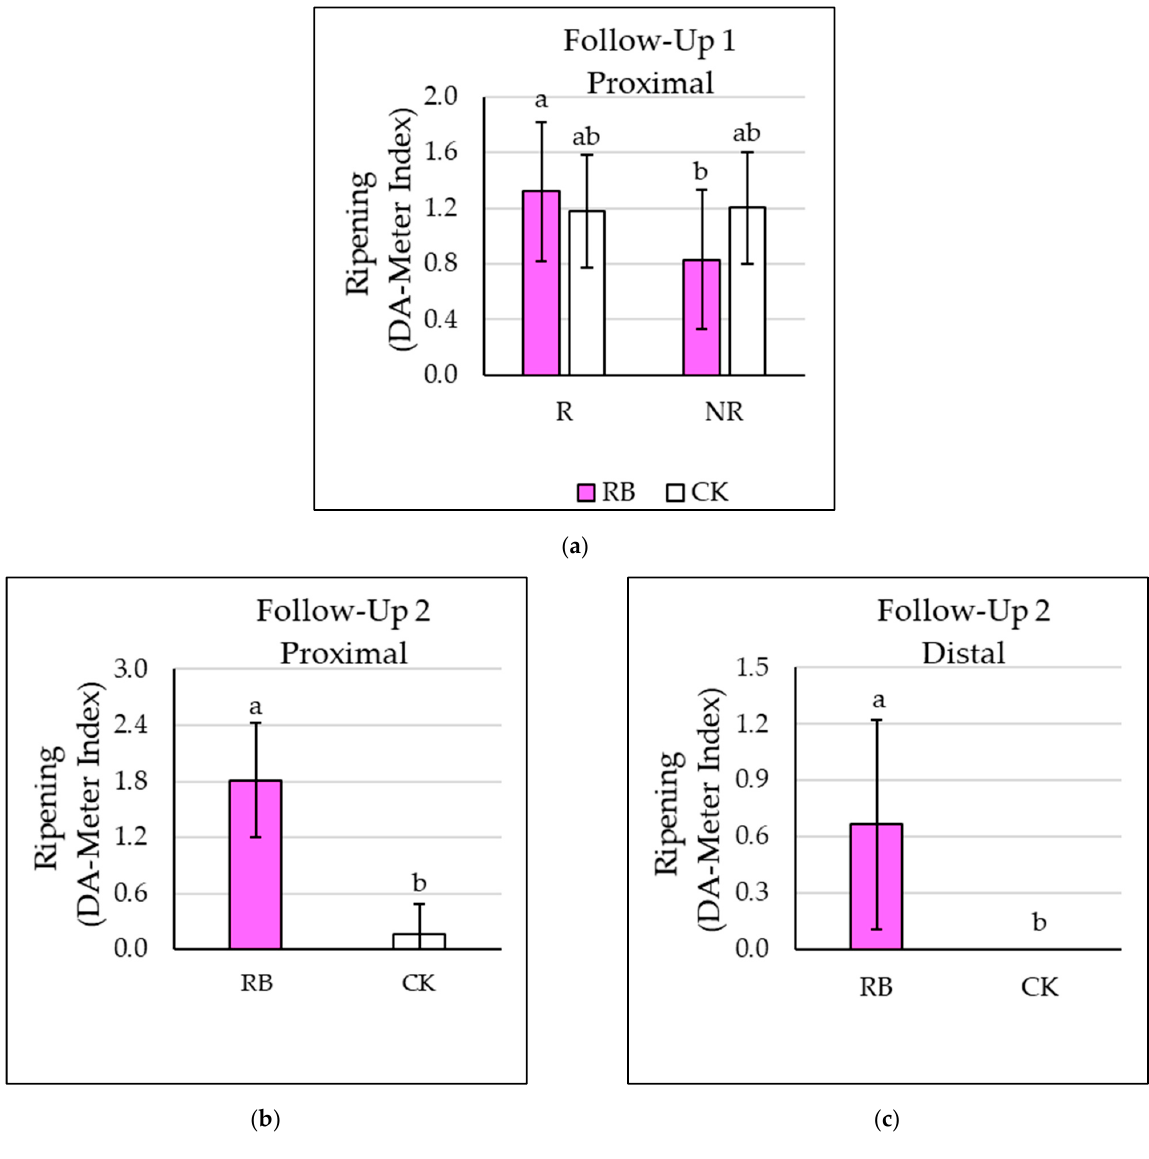
Figure 2. Effect of light (supplemental red and blue LED light, RB, and natural light only, CK) and defoliation (leaves early removal, R, and no-removal, NR) on ( a ) proximal fruits of Follow-Up 1 ( b ) proximal fruits of Follow-Up 2, and ( c ) distal fruits of Follow-Up 2. Different letters indicate significant differences at ANOVA (significant level p ≤ 0.05). Vertical bars represent standard errors. Table 3. Effects of the two separated factors, light (supplemental red and blue LED light, RB, and natural light, CK) and defoliation (early leaf removal, R, and no-removal, NR), on fruit volume (cm 3 ) in proximal and distal tomatoes of Follow-Up 1 and Follow-Up 2 Different letters indicate significant differences at ANOVA (significant level p ≤ 0.05). Fruit Volume Fruit Volume Follow-Up 2 (cm 3 ) Follow-Up 1 (cm 3 )